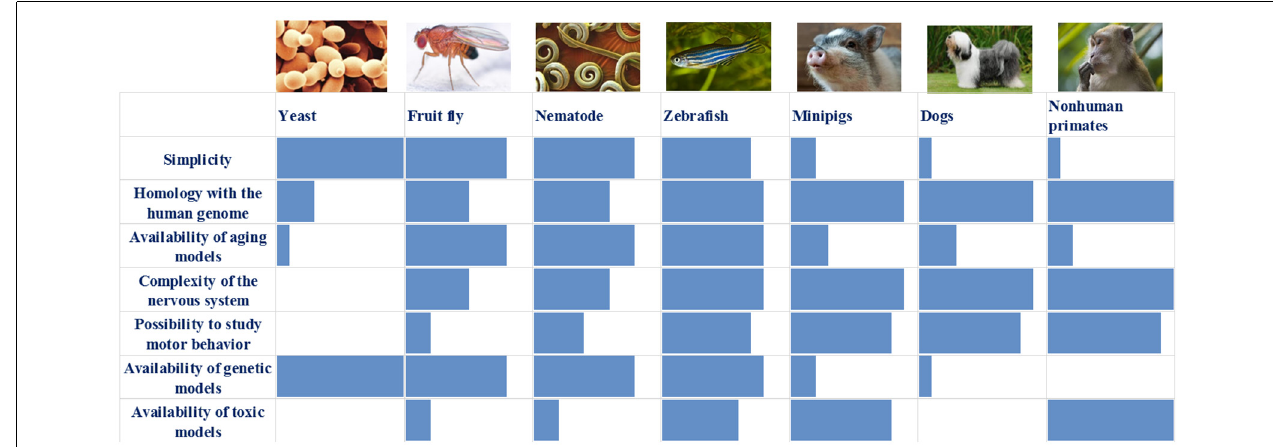
FIGURE 1 | Comparison of the main characteristics of the described models: blue box—assessment of individual characteristics of the model (0–10 points).